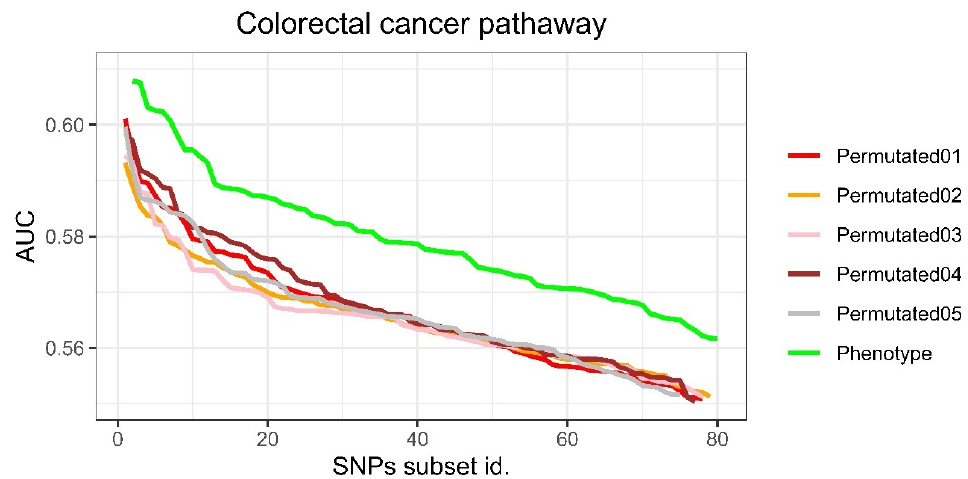
Figure 8. AUC values of the 80 iterations performed for the colorectal cancer pathway in the case of cases and controls (phenotype) and five different permutations.